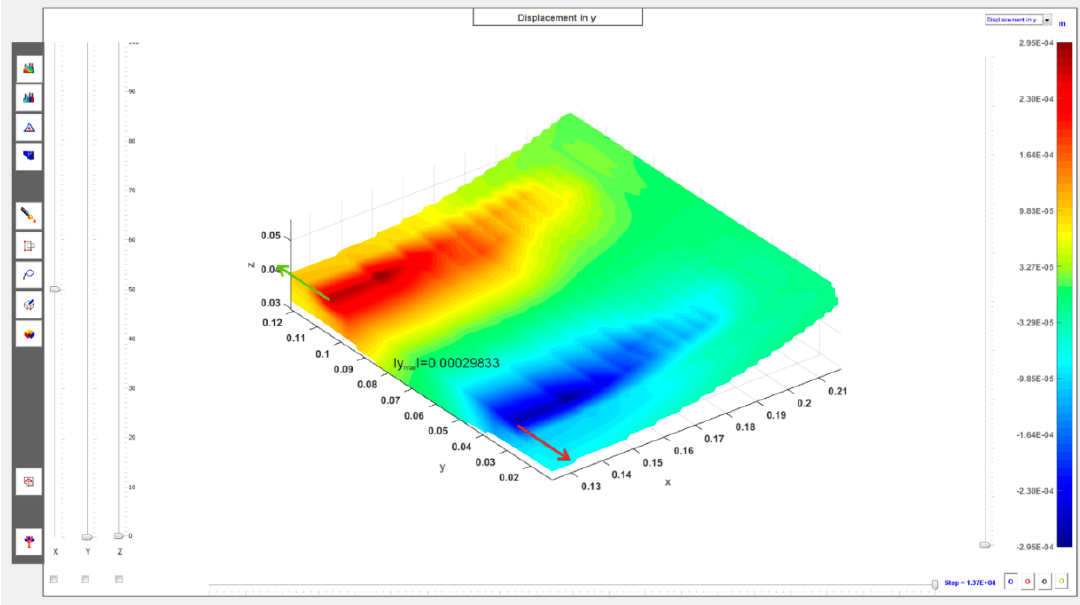
Figure A13. Displacements (in meters, middle section) in sand layer in parallel y direction to roller axis: h = 3.0 mm, p opt = 3.1 bar ( N = 1550 N).